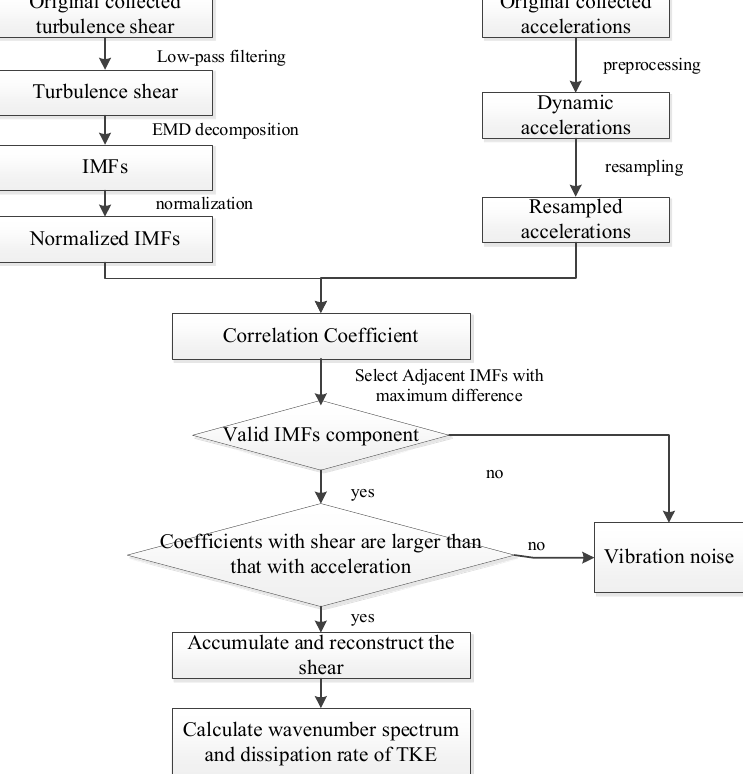
Figure 3. Flow chart of the improved algorithm.